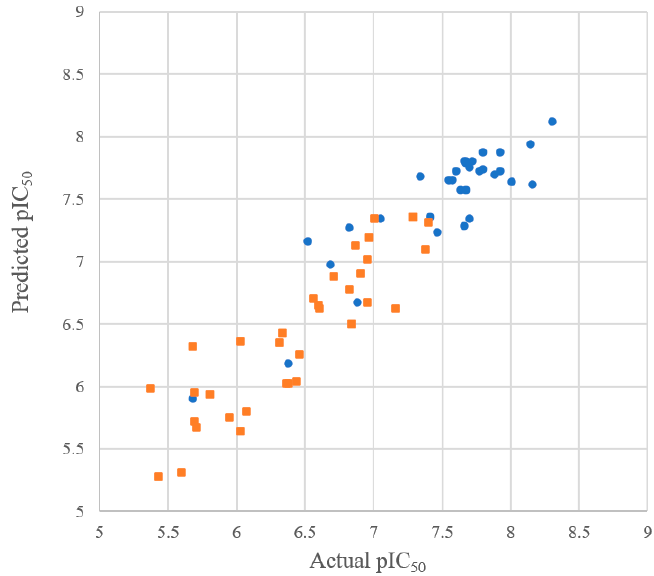
Figure 2. Observed vs. predicted values of the hybridized CoMFA model. 8-Amino-4,5-dihydro-1 H -pyrazolo [4,3- h ]quinazoline-3-carboxamides (series A; orange) and thiophene-2-carboxamide (series B; cyan).